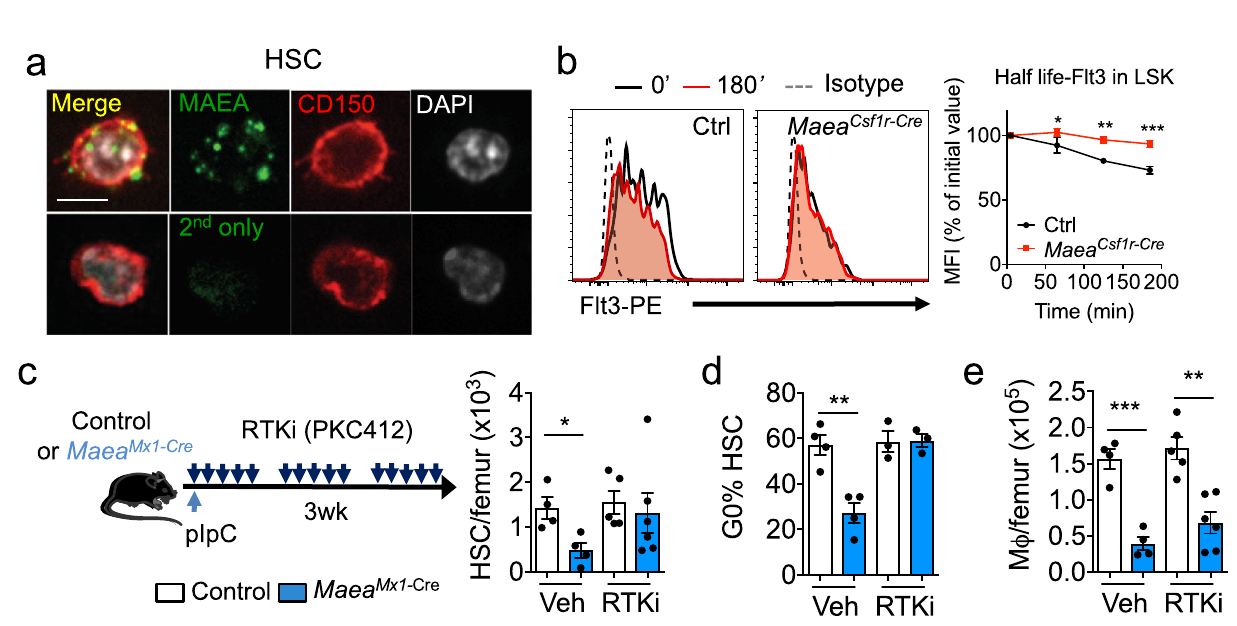
Fig. 3 MAEA regulates cytokine receptor ubiquitination and stability in hematopoietic stem cells (HSCs). a Representative immuno fl uorescence images showing MAEA and CD150 expression in HSCs using cells from two independent experiments of four mice. Scale bar = 10 μ m. b Representative histograms and FACS evaluation of Flt3 half-life in control and Maea Csf1r-Cre LSK cells incubated in the presence of 50 μ M cycloheximide ( n = 4